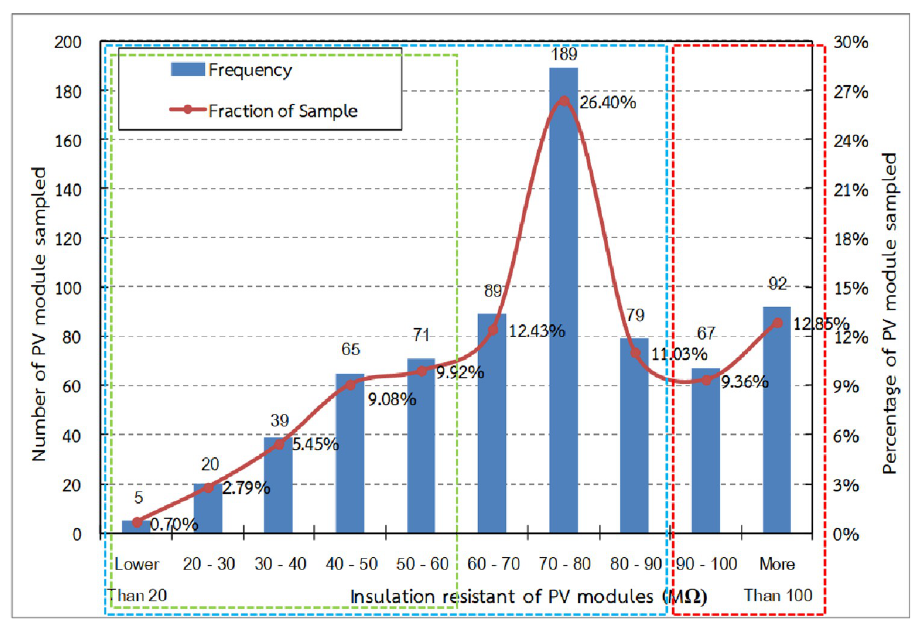
Fig 8. Insulation resistance distribution of the sampled PV